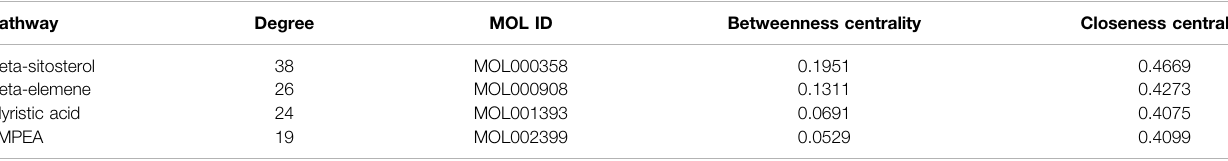
TABLE 7 | Main active compounds characterization parameters. Pathway Beta-sitosterol